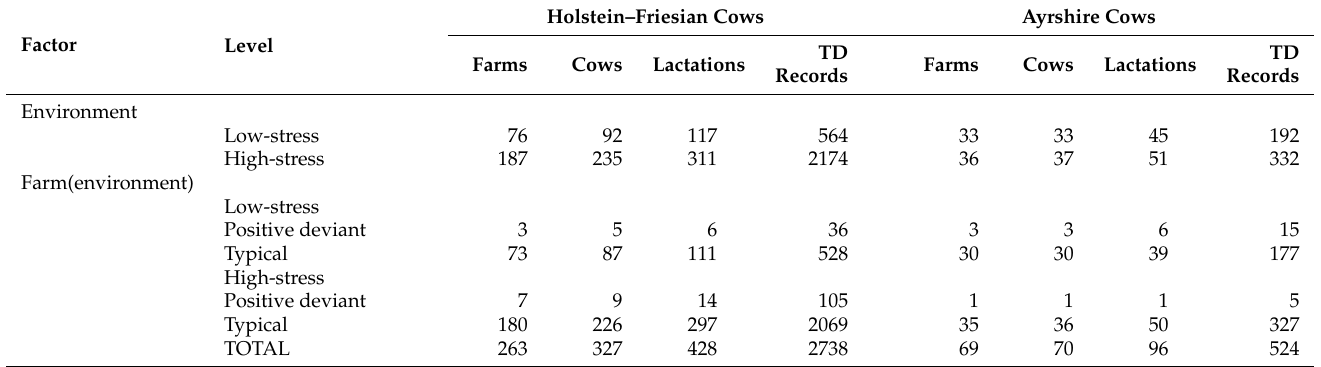
Table 1. The number of dairy farms, cows, lactations and monthly test-day (TD) milk production records available for analysis of lactation curve